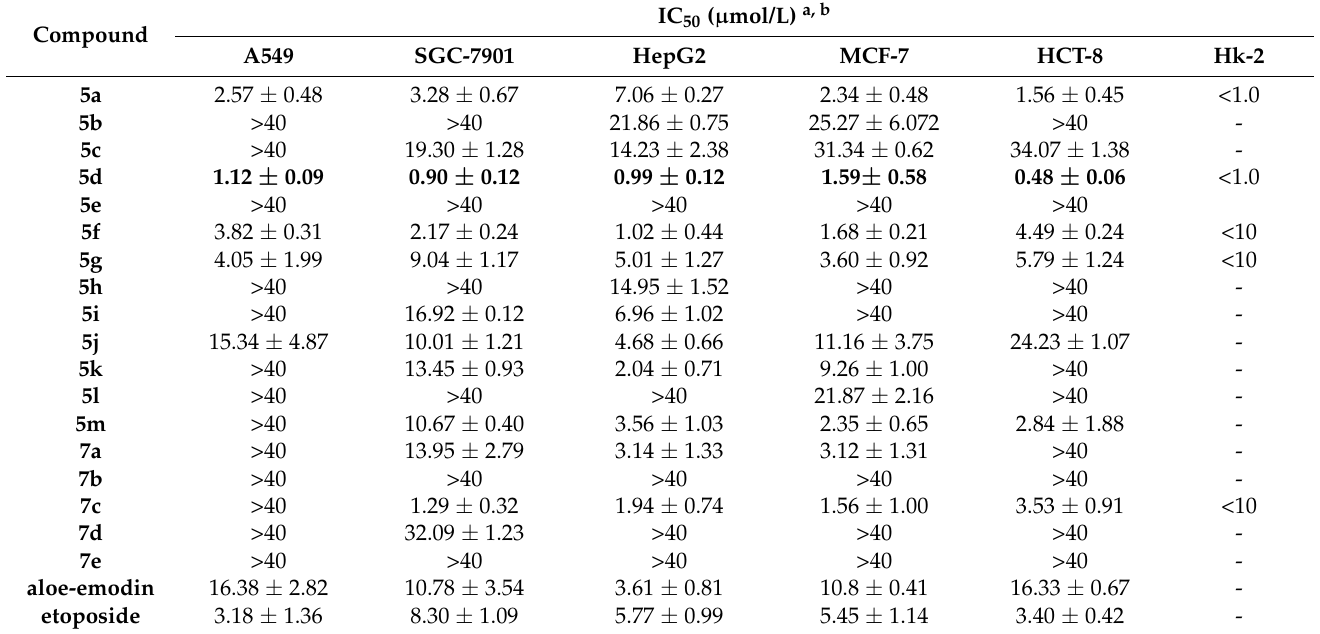
Table 2. In vitro antitumor activities of target compounds 5a – m and 7a – e